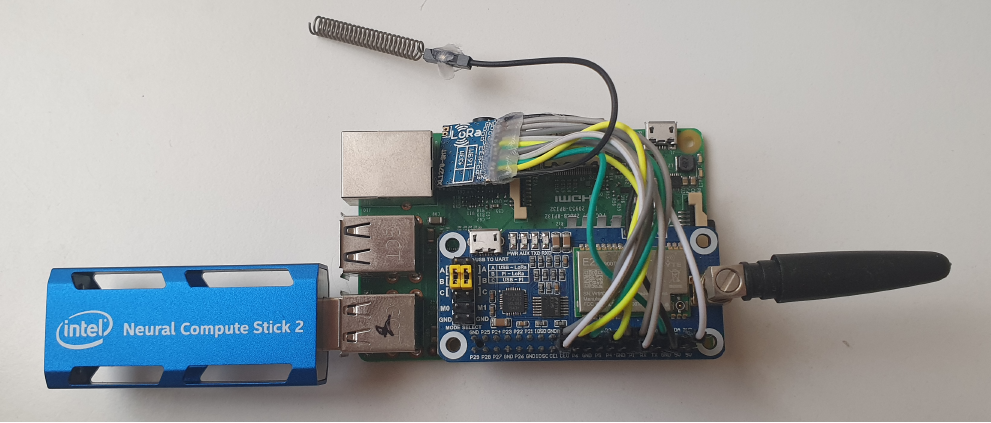
Figure 7. Fog-artificial intelligence (AI)